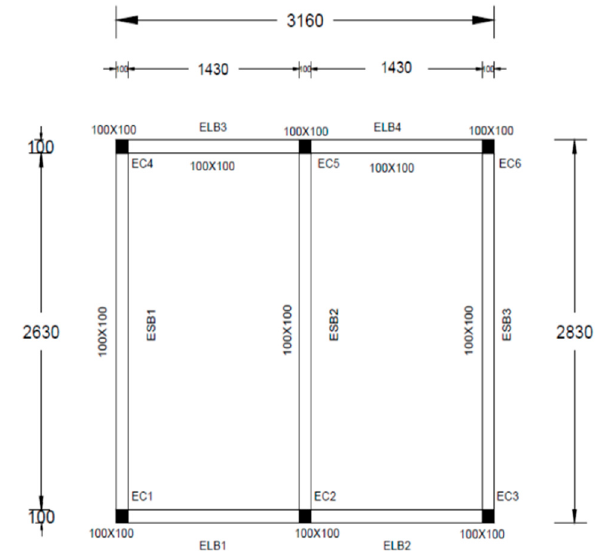
Figure 7. Structural plan of the model house.